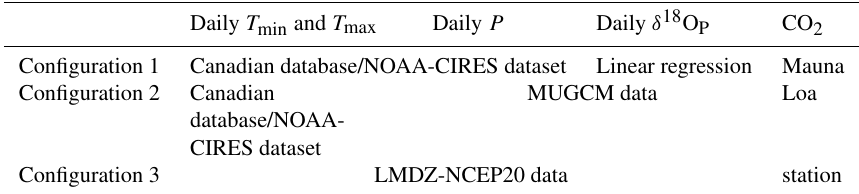
Table 2. Climate input data for all tested